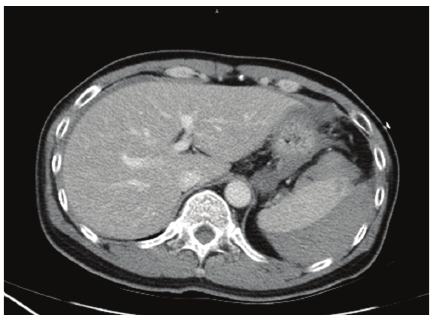
Figure 2: Massive hyperdense ascites surrounded around the spleen without free